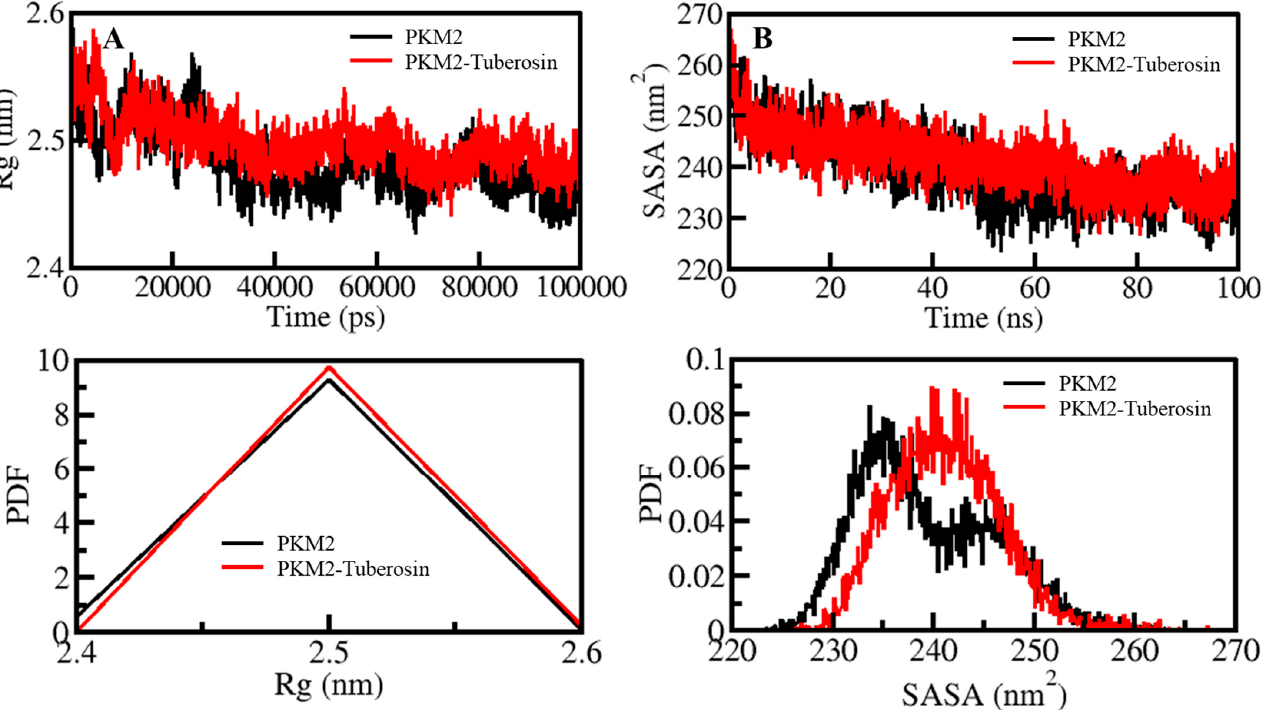
Figure 3. Structural compactness and folding of PKM2 after Tuberosin binding. ( A ) The R g distribu- tion as a function of time. ( B ) SASA plot of PKM2 as a function of time before and after Tuberosin binding. The lower panels show the distribution of parameters as a PDF.